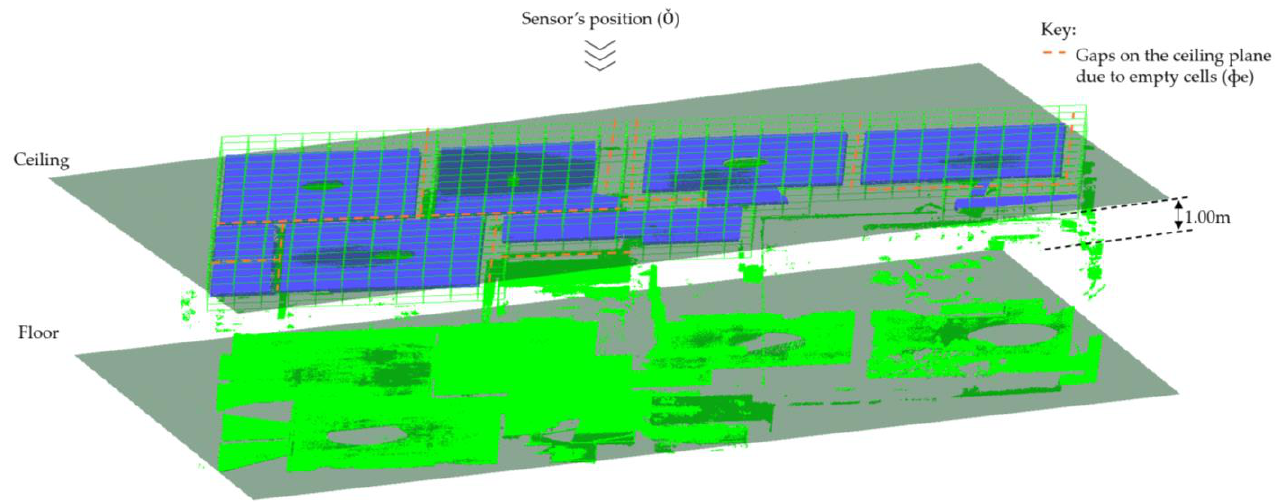
Figure 12. Alignment and position of the overhead ceiling and points below the ceiling plane for detecting candidate points for the corresponding beam below.